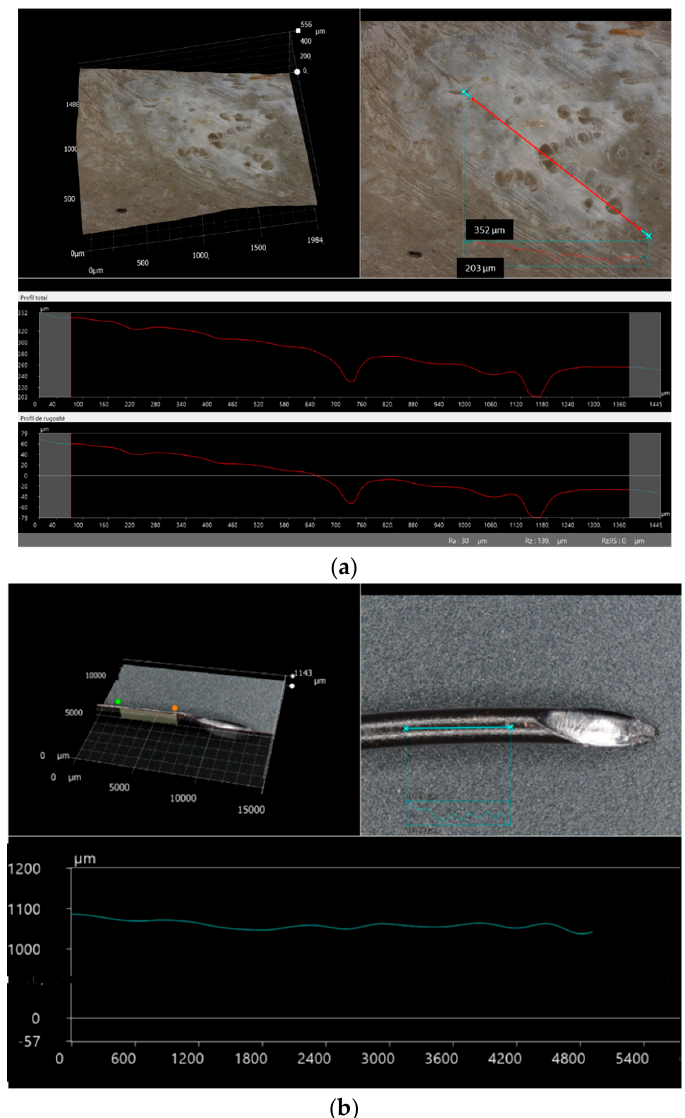
Figure 8. Surface roughness of as-received ( a ) PF and ( b ) PLA filaments measured using optical